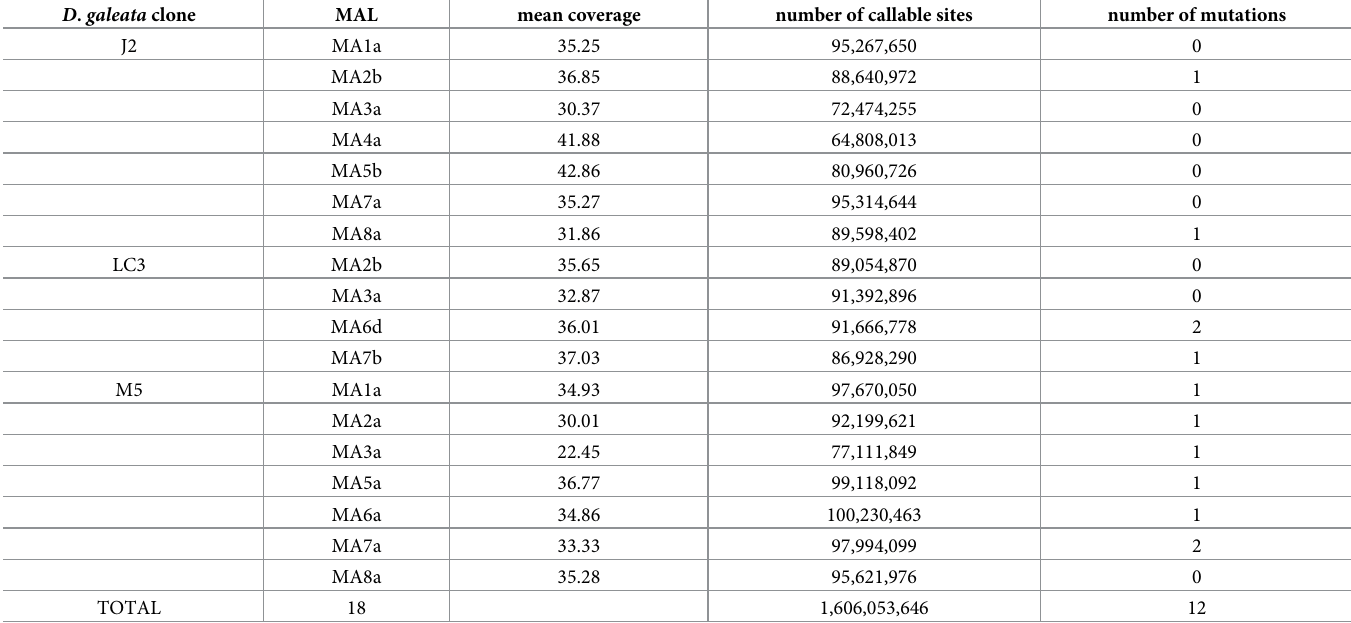
Table 1. Information on the short-term mutation accumulation lines (MAL) from three clones of D . galeata investigated. D . galeata